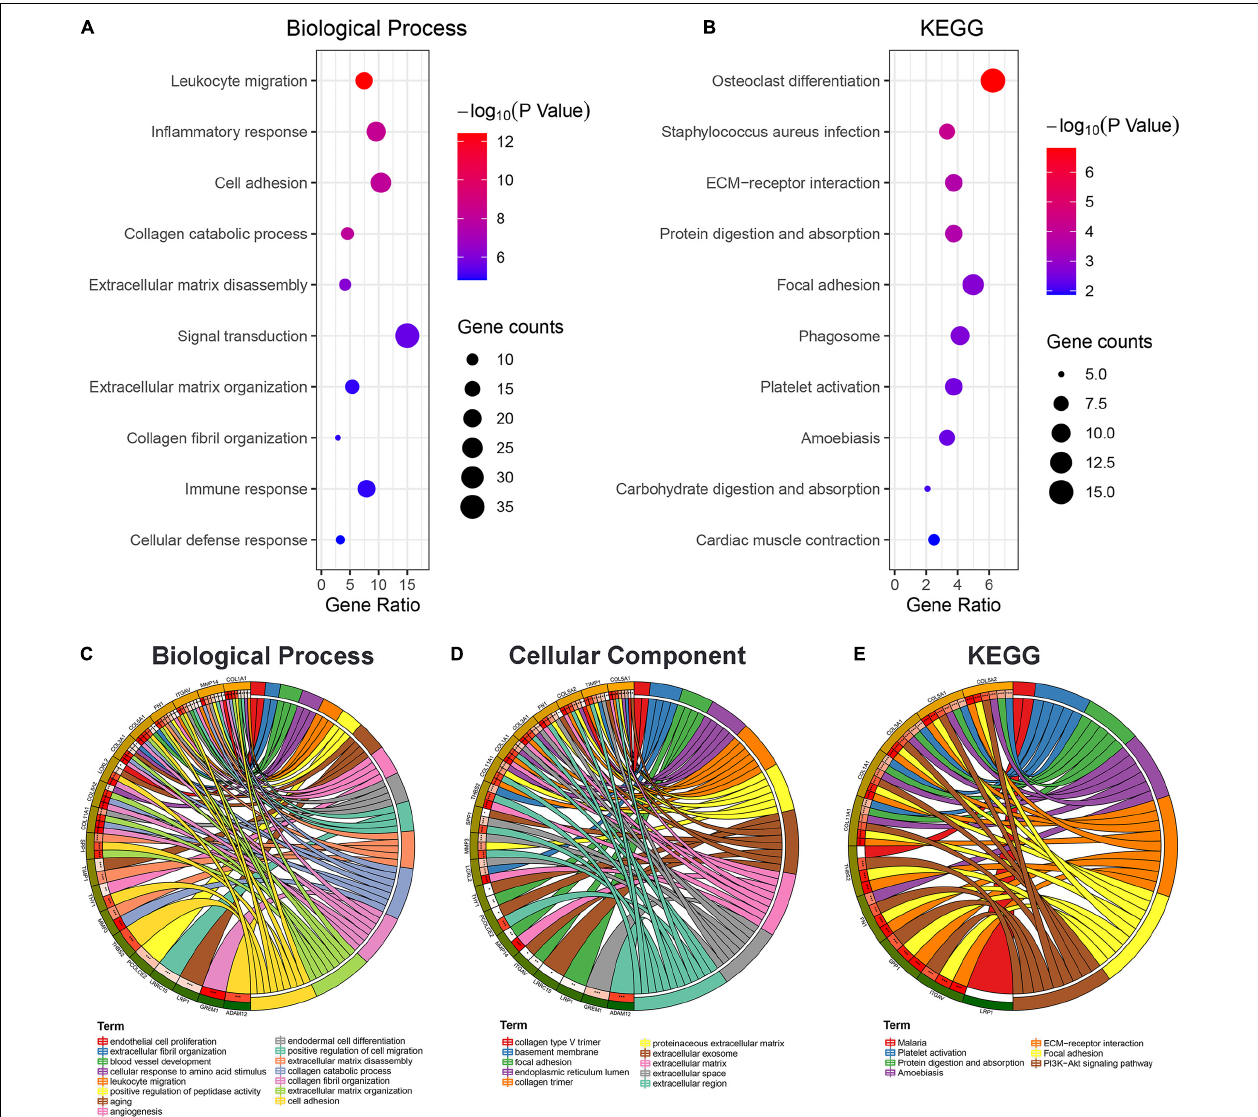
FIGURE 4 | Gene ontology (GO) and Kyoto Encyclopedia of Genes and Genomes (KEGG) enrichment analysis. The bubble diagram displayed the biological function (A) and KEGG (B) enrichment analysis results of the brown module genes. Biological function (C) , cellular component (D) , and KEGG (E) enrichment analysis was performed on 19 epithelial–mesenchymal transition (EMT)-related genes in the brown module, and the chord diagram was used to show the enriched GO/KEGG terms and statistical differences. * p < 0.05, ** p < 0.01, and *** p <